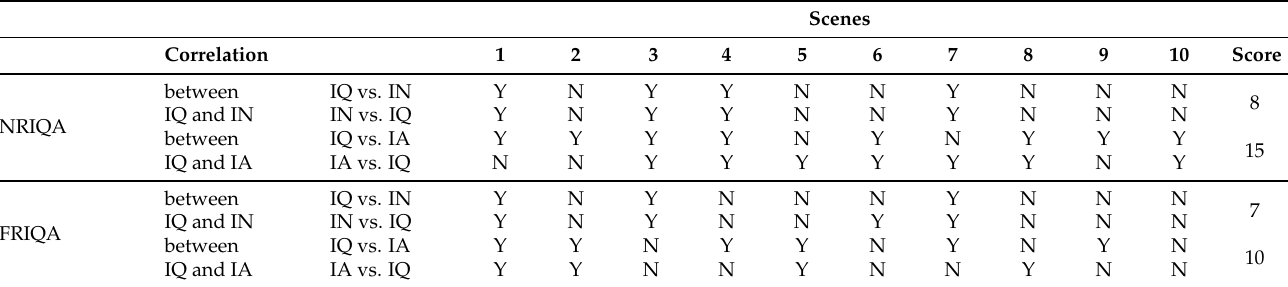
Table 2. Correlation between IQ and IA and IN in the two cases FRIQA and NRIQA. IQ vs. IN: “Is the IN rank of the highest IQ photo higher than that of the lowest one?”. IN vs. IQ: “Is the IQ rank of the highest IN photo higher than that of the lowest one?”. IQ vs. IA: “Is the IA rank of the highest IQ photo higher than that of the lowest one?”. IA vs. IQ: “Is the IQ rank of the highest IA photo higher than that of the lowest one?”. Y: Yes. N: No. Score means correlation